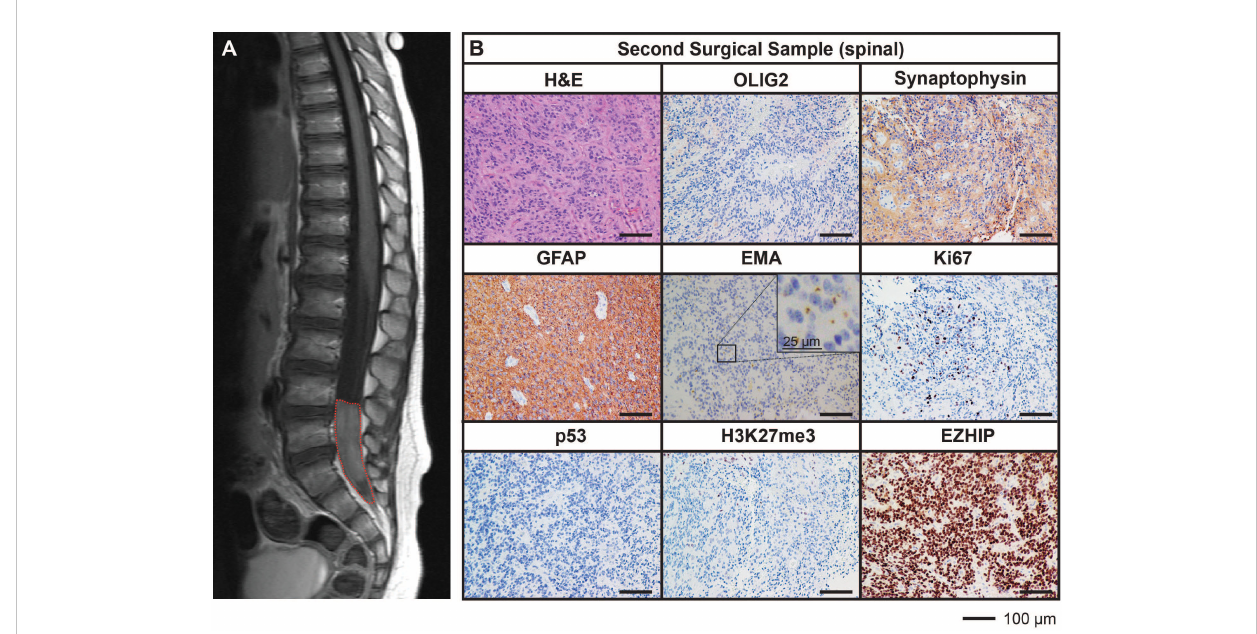
FIGURE 2 MRI and histological assessments of the second surgical sample (spinal) were consistent with the lesion being a metastasis of the primary PFA EPN. (A) MRI depicting a spinal metastasis in the terminal thecal sac ( red dotted line ). (B) The tumor tissue was stained with H&E or using IHC with the antibodies indicated ( brown ) followed by hematoxylin counterstain ( blue ). Histological fi ndings were consistent with the features of the primary tumor. Ki67 proliferative index was estimated to be 25%. Scale bars are as